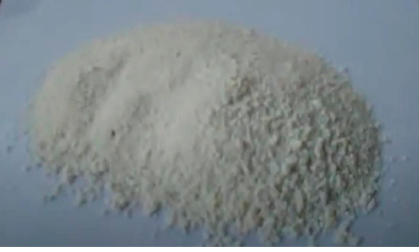
Figure 2: Image of SiO